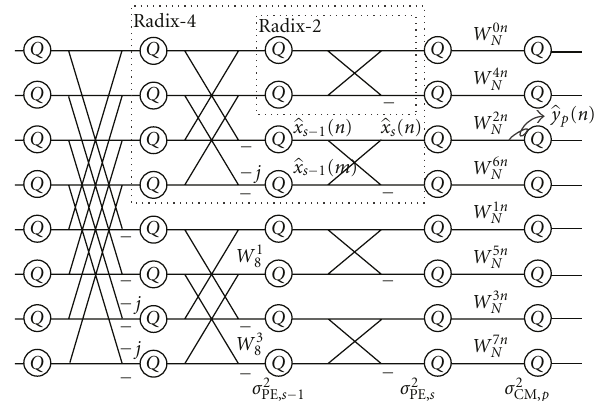
Figure 5: Signal flow graph of the radix-2 3